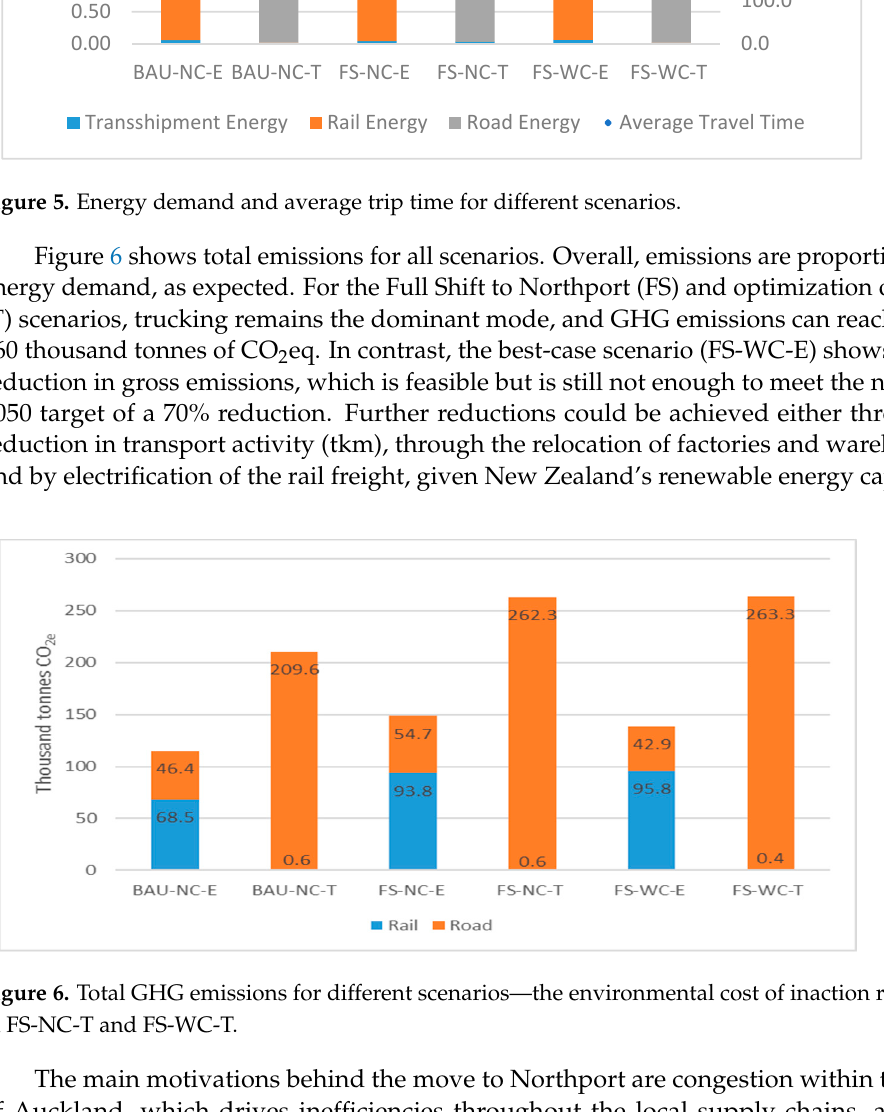
Figure 6. Total GHG emissions for different scenarios—the environmental cost of inaction reflected in FS-NC-T and FS-WC-T.